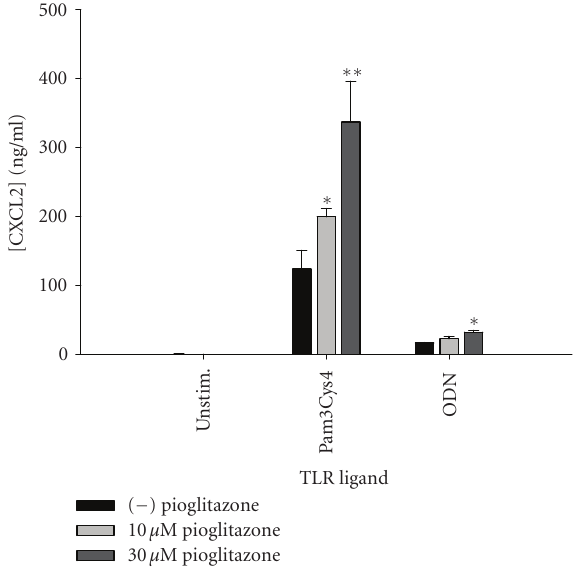
Figure 7: Pioglitazone augments microglial CXCL2 production in response to Pam3Cys4 and ODN. Primary microglia were plated at 2 × 10 5 cells/well in 96-well plates and incubated overnight. The following day, cells were pretreated for 1 hour with the indicated concentrations of pioglitazone prior to the addition of Pam3Cys4 or ODN. Cell-conditioned supernatants were collected at 24 hours following TLR ligand exposure, whereupon CXCL2 levels were determined by ELISA. Significant di ff erences between microglia treated with TLR ligands alone versus TLR ligands + pioglitazone are noted with asterisks ( ∗ P < . 05; ∗∗ P < . 001). Results presented are representative of two independent